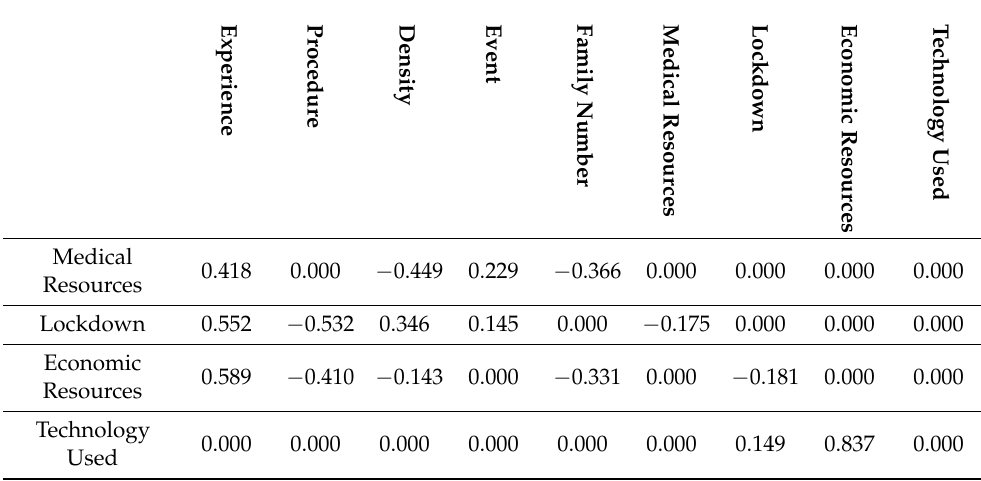
Table 9. Standardized direct effects of exogenous variables on endogenous variables.